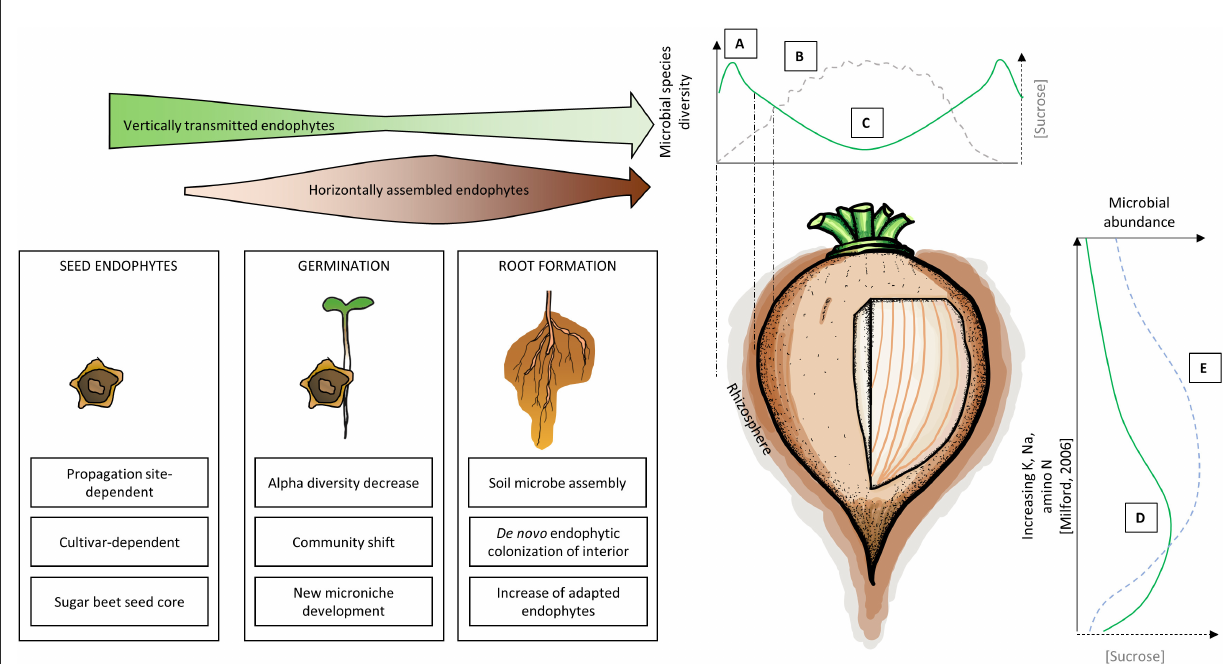
FIGURE1 Simplified temporal (Left) and spatial (Right) holobiont model of sugar beet taproot. The arrow width indicates the relative importance of vertically and horizontally assembled endophytes (Top Left) . A: Root exudation and/or endophyte release leads to an increase in measured diversity in taproot-associated rhizosphere communities (Zachow et al., 2014; Cardinale et al., 2020; Wolfgang et al., 2020). CFU number in the peel can exceed the CFU number in the rhizosphere (Okazaki et al., 2014). B: Relative sugar content increases toward the center, higher in proximity to vascular bundles. Sucrose further decreases with increasing distance to the secondary cambia (Milford, 2006; Hoffmann and Kenter, 2018). C: Diversity decreases toward the center, while the relative abundance of copiotrophic bacteria increases (Lilley et al., 1996; Okazaki et al., 2014). D: Microbial abundance is highest in the root elongation zone near the root tip, with a high relative abundance of exudate responders, e.g., Variovorax and Pseudomonas (Jacobs et al., 1985; Lübeck et al., 2000; Shi et al., 2009a). E: The sugar content of beet tissue is highest in lower taproot (Milford,